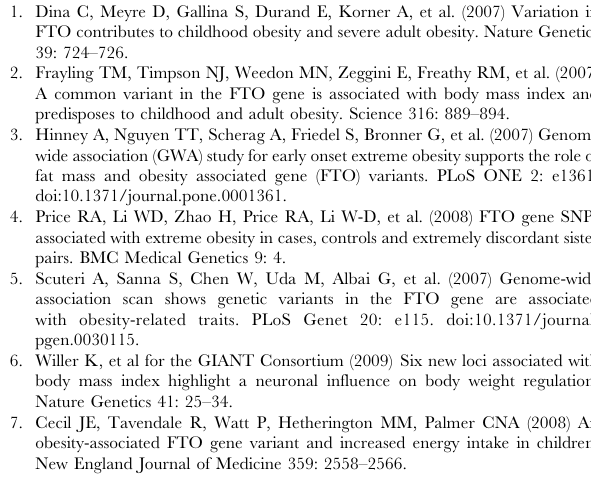
Table S2 Cross sectional relationships between variation at FTO rs9939609 and birthweight and early measures of